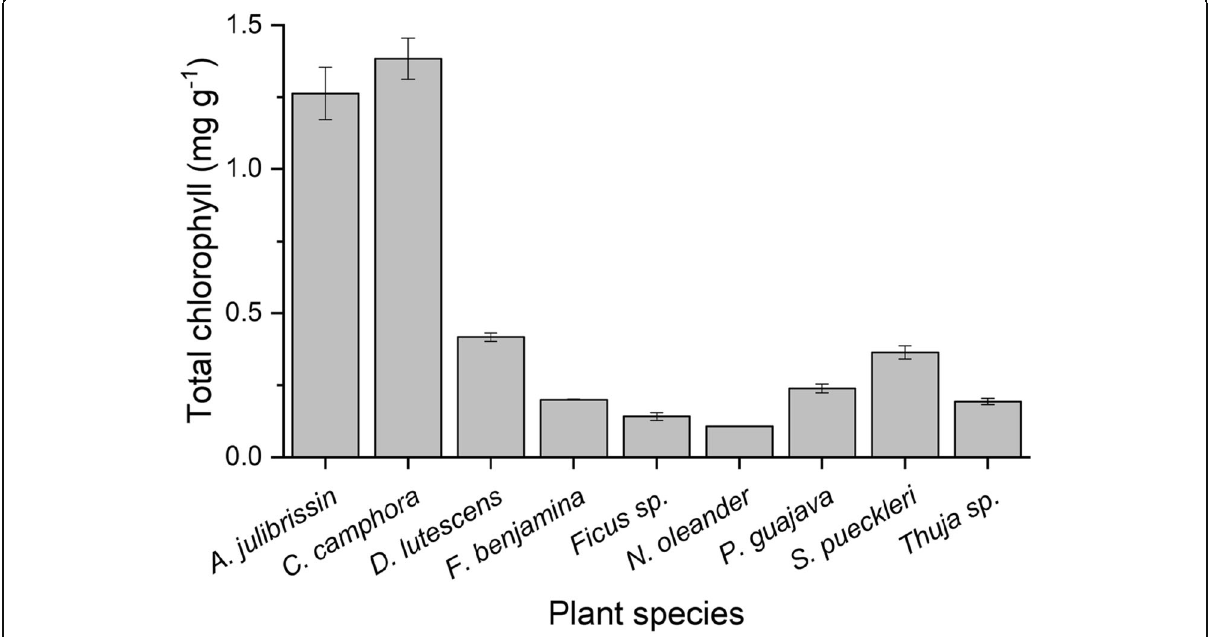
Fig. 3 Average total chlorophyll content of the selected plant species; error bars represent the standard deviation ( n =